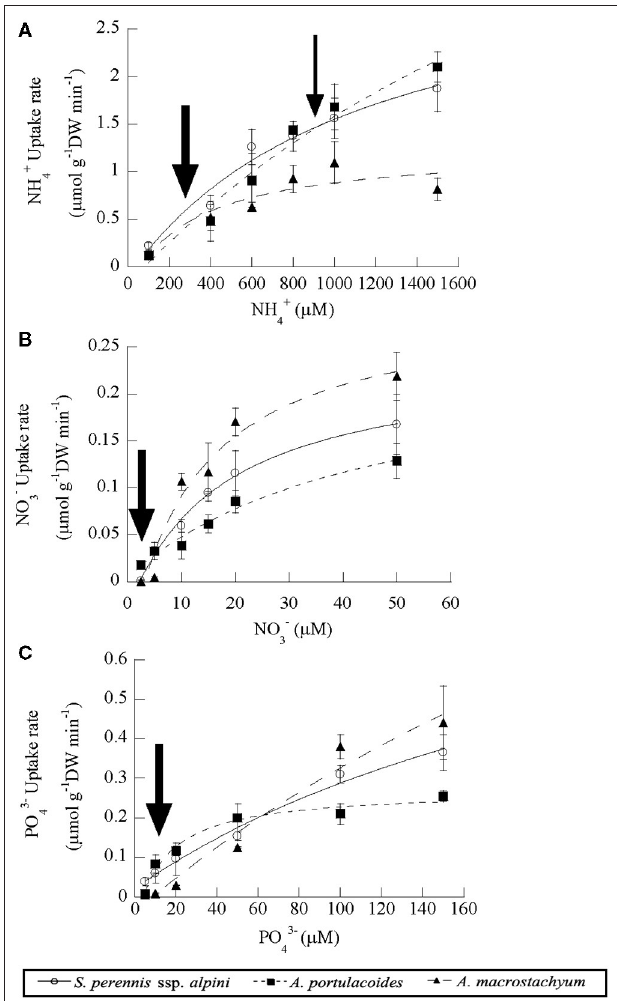
FIGURE 5 | Uptake kinetics of ammonium (A) , nitrate (B) and phosphate (C) in the three species of the study ( S. perennis ssp. alpini, A. portulacoides and A. macrostachyum ). Bars represent standard deviation ( n = 4). The thick and thin arrows point out the uptake at modal and submodal concentrations of nutrients,